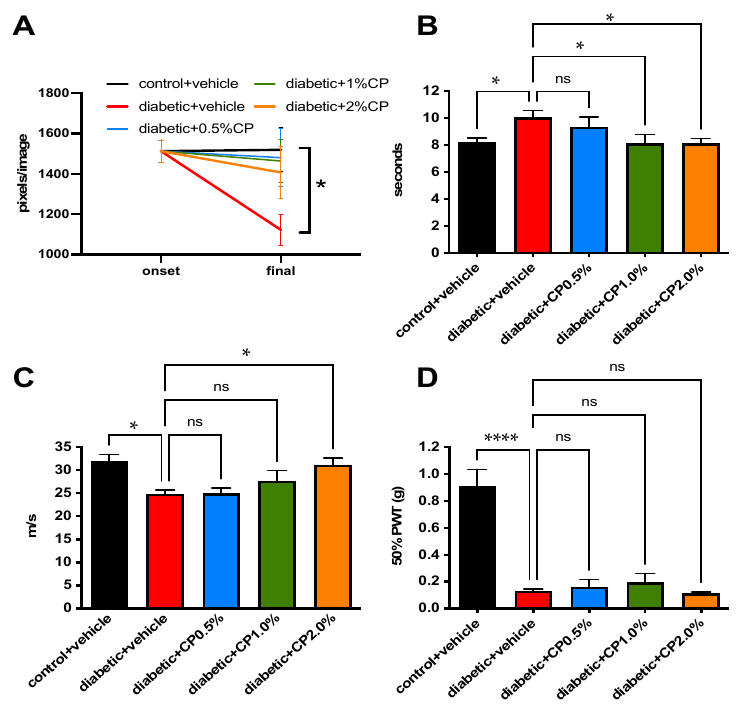
Figure 2. Prevention of neuropathy by topical cyclopentolate in diabetic mice. Sub-basal nerve plexus density ( A ), paw response latency to heat ( B ), sciatic motor nerve conduction velocity ( C ), and paw 50% response threshold to von Frey filaments ( D ) after 8 weeks of diabetes, with daily treatment to the eye with vehicle or cyclopentolate (CP) for the last 4 weeks. Data points are group mean ± SEM with between group analysis by one way ANOVA followed by Dunnett’s Post hoc test. * = p < 0.05 and **** = p < 0.0001 vs. vehicle-treated diabetic mice. ns: not